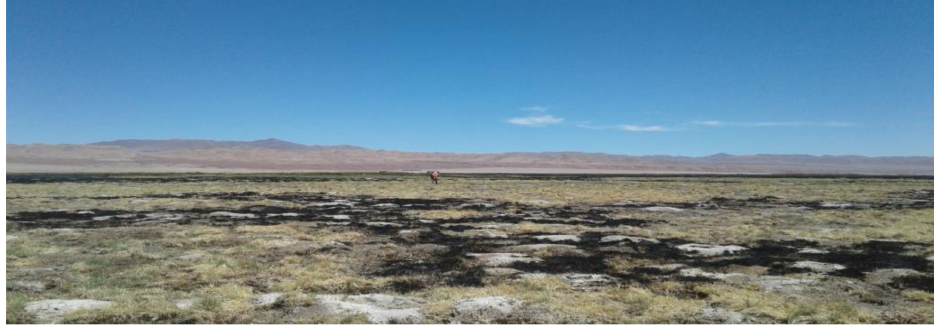
Figure 9. Schoenoplectus americanus meadows at Tliopozo that were damaged by an intentional fire in November 2017; authors’